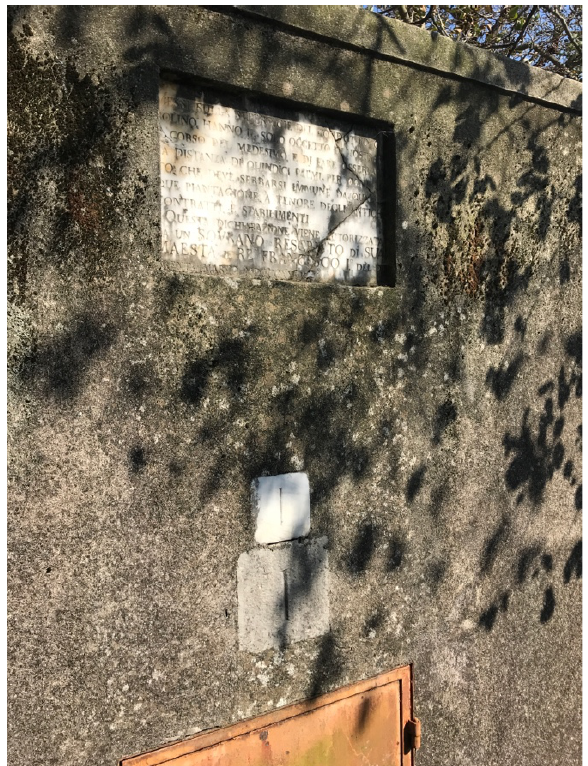
Figure 1 . ‘Carolino’ Aqueduct. Turret n.1 close Fizzo Spring area.